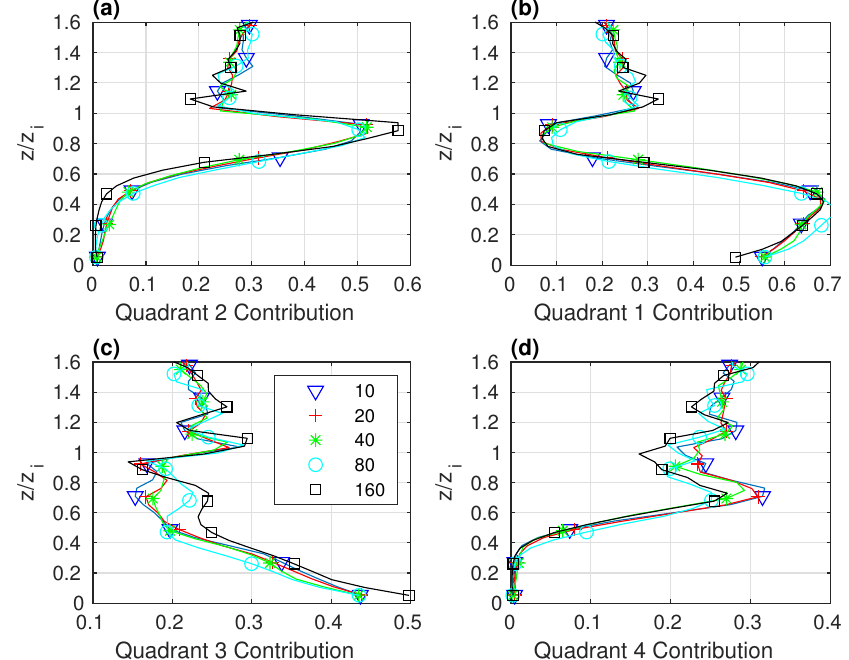
Figure 11. Effect of coarse graining data from the CBL1 simulations to the 160 m grid on the partitioning of the resolved potential temperature flux into different quadrants. Relative contributions of the flux in each quadrant, computed as |(cid:104) w (cid:48) θ (cid:48) (cid:105) i | / ∑ i |(cid:104) w (cid:48) θ (cid:48) (cid:105) i | , are shown for ( a ) Quadrant 2, ( b ) Quadrant 1, ( c ) Quadrant 3 and ( d ) Quadrant 4. Each line is for a simulation with a different grid length, the values in m being indicated in the